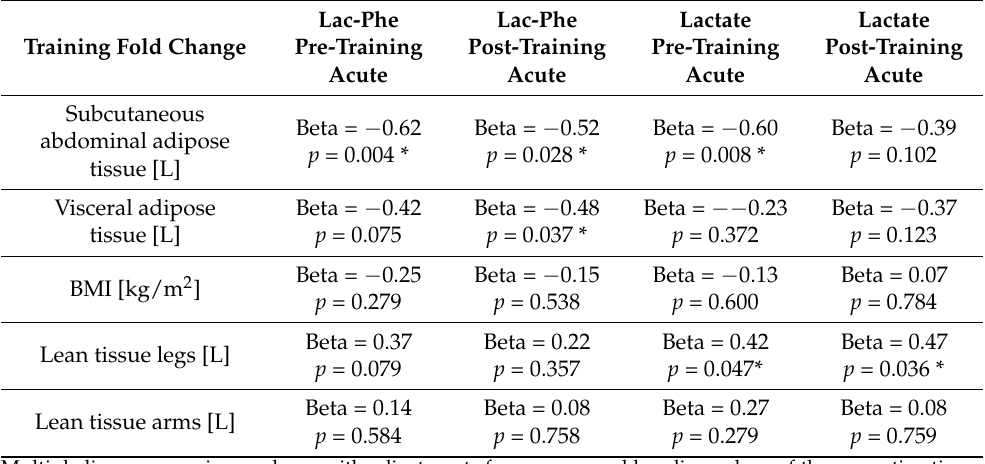
Table 2. Association of the increased Lac-Phe and lactate levels after acute exercise with the training